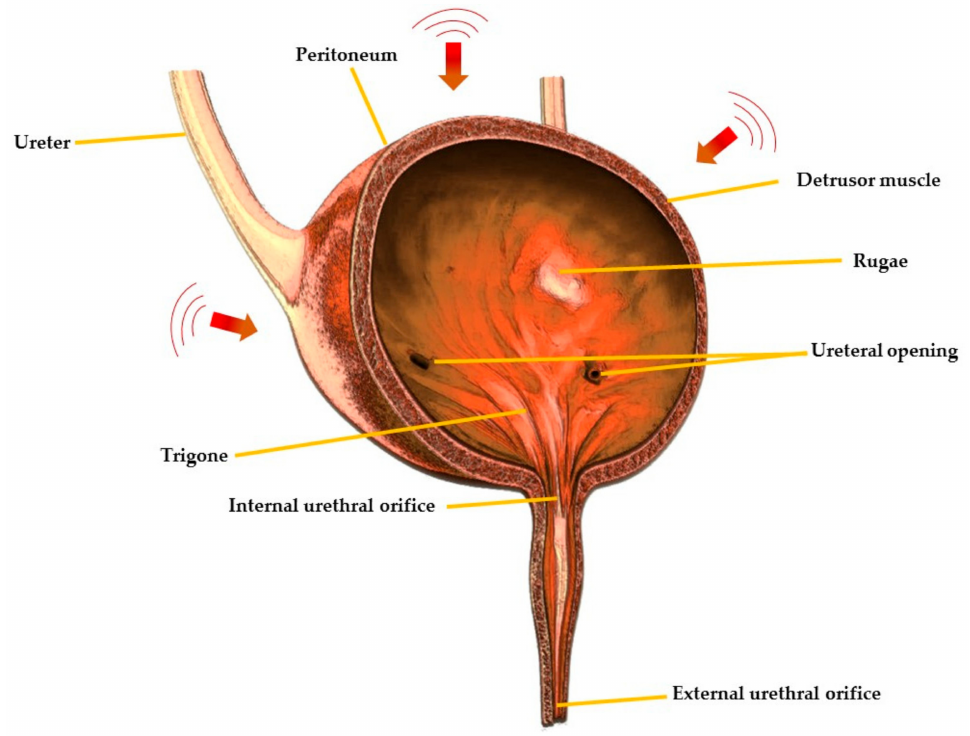
Figure 1. Cross-sectional view of urinary bladder showing different regions. OAB management strategies include non-pharmacological and pharmacological ap- proaches. Non-pharmacological interventions include behavioural and bladder train- ing, whereas pharmacologic therapies include muscarinic receptor antagonists or anti- muscarinic drugs (tolterodine, solifenacin, darifenacin, propiverine, oxybutynin, trospium chloride), α -adrenoceptor antagonists (alfuzosin, doxazosin), β -adrenoceptor antagonists (terbutaline, salbutamol), vitamin D analogues (elocalcitol), a combination of drugs (anti- muscarinic + α -adrenoceptor antagonist), phosphodiesterase inhibitors (sildenafil, tal- adafil), cyclooxygenase inhibitors (flurbiprofen, indomethacin), voltage-gated